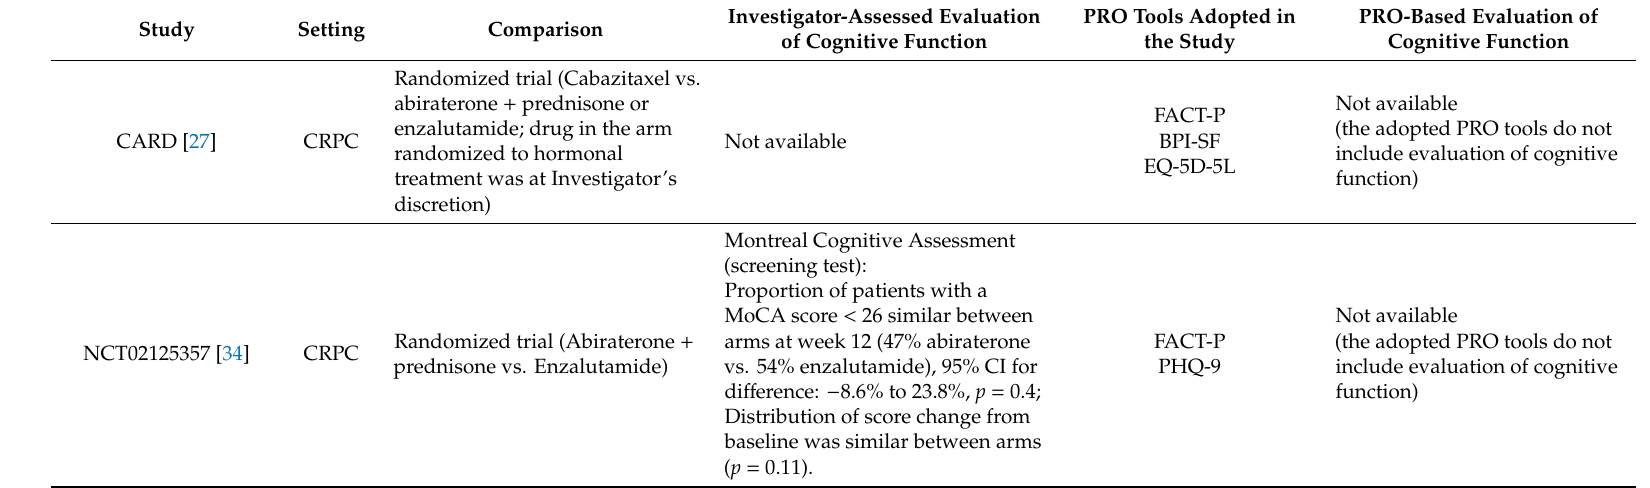
Table 2. Trials testing both abiraterone and